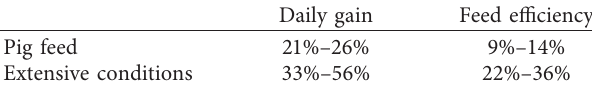
Table 1: Application experimental data of BFA on fat